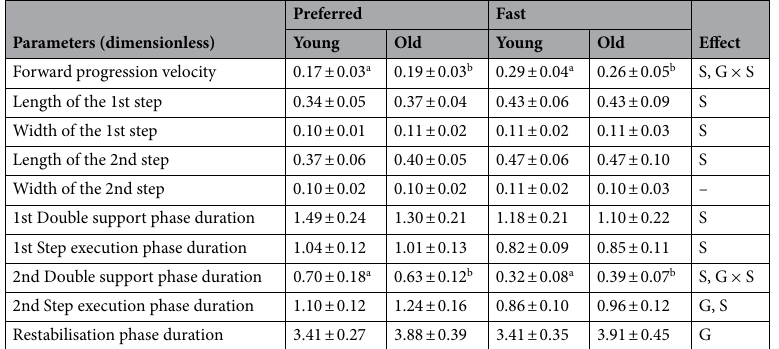
Table 2. Normalized spatiotemporal parameters for young and older participants in the preferred and fast speed conditions. Values are presented as mean ± SD. Velocity was normalized by (cid:31) g · l , distances were normalised by l and durations were normalised by (cid:31) l / g . With g = 9.81 m s −2 and l = body height (m). Absence of group, speed and interaction effects ( P > 0.05) was indicated by ‘_’. Significant group effect is indicated with ‘G’. Significant speed effect is indicated with ‘S’. ‘ G × S ’ indicated significant Group × Speed interaction. Means sharing similar letters differ